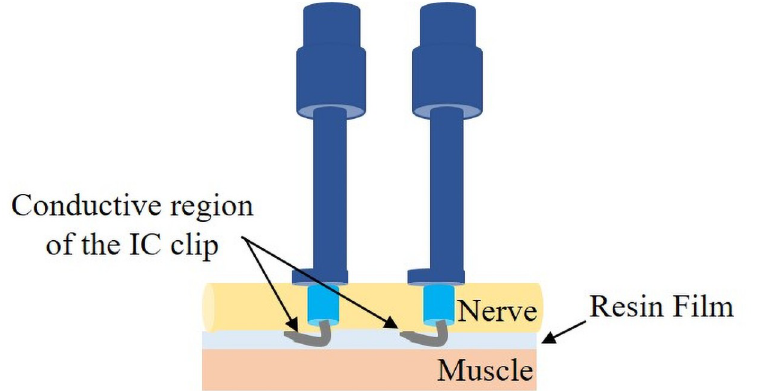
Fig 2. Schematic illustration of the impedance measurements with resin film between the nerve and integrated circuit (IC) clips.